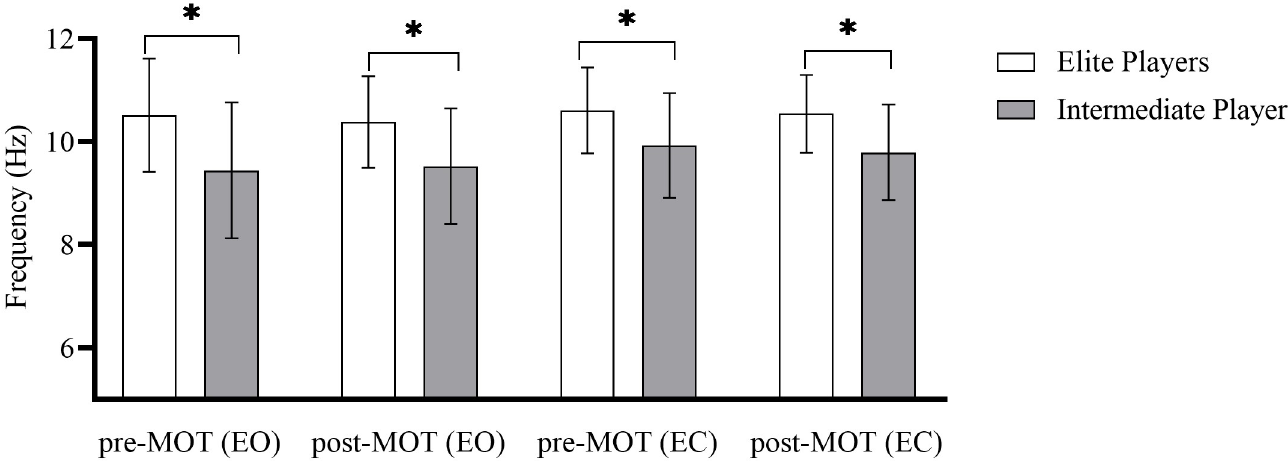
Fig 3. Changes in individual alpha peak frequency associated with MOT task engagement. Data bars are means, and error bars are standard deviation. MOT represents multiple object tracking; EC, eyes closed; and EO, eyes open; � p < 0.05.